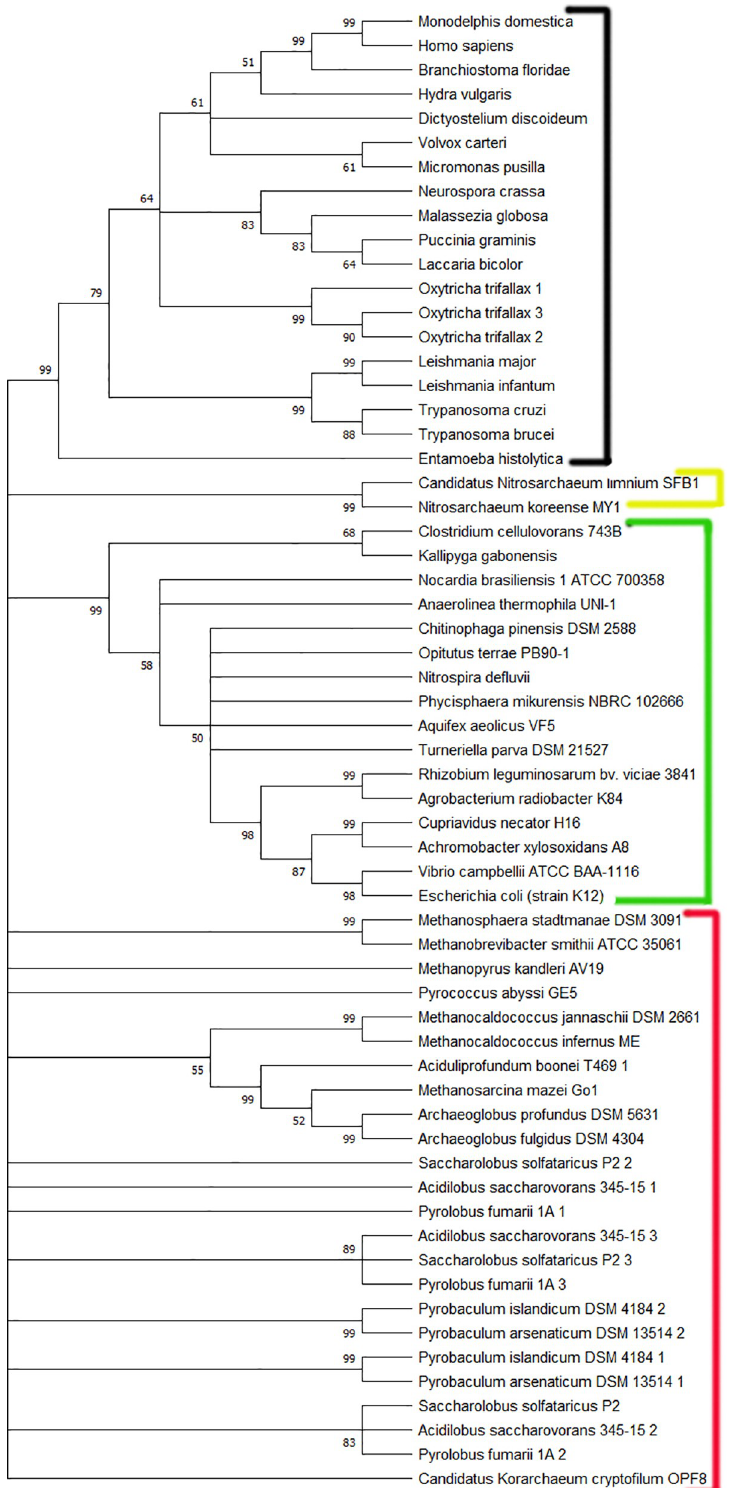
Fig 6. A phylogenetic tree of 61 amino acid sequences representing species from all domains of life. Black line represents Eukarya domain, Green line represents Bacteria domain, Yellow line represents Korchaeota, and Red line represents Archaea domain. It can be observed that all bacterial species originate from a single node, and all eukaryal species descended from a single, but separate node. However, archaeal species are separated throughout the phylogenetic